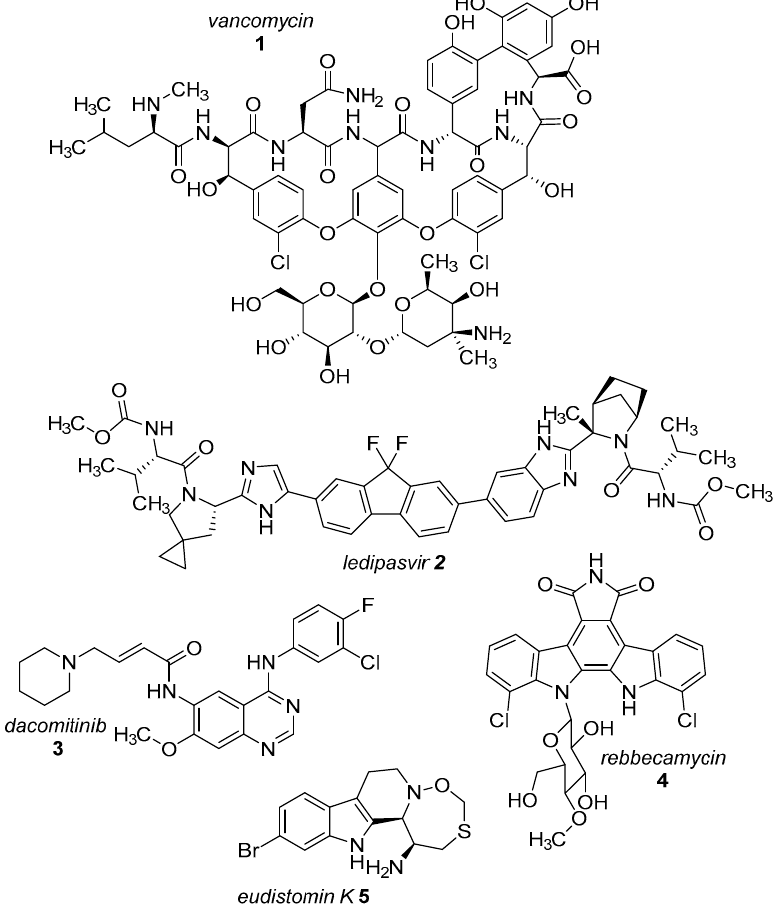
Figure 2. Examples for halogenated active agents.